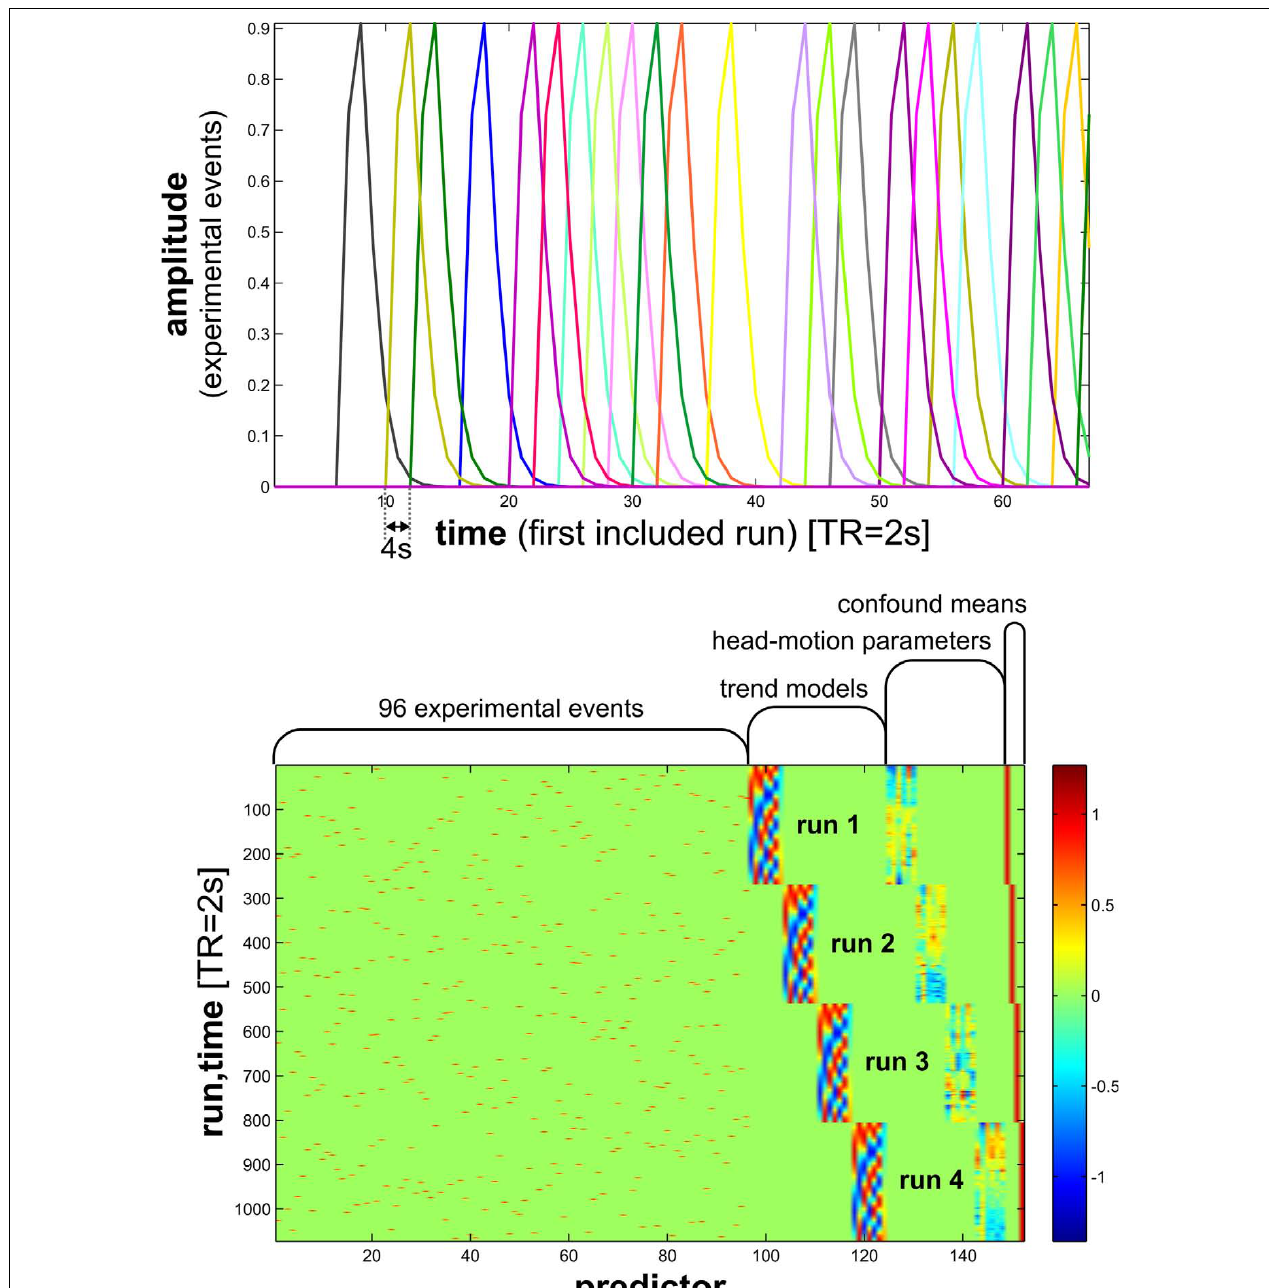
occurs exactly once in each run. The condition sequence is independently randomized for each run.) The bottom panel shows the complete design matrix with predictor amplitude color coded (see colorbar on the right). In addition to the 96 predictors for the experimental conditions, the design matrix also includes components modeling slow artefactual trends and residual head- motion artefacts (after rigid-body head-motion correction), and a confound-mean predictor for each